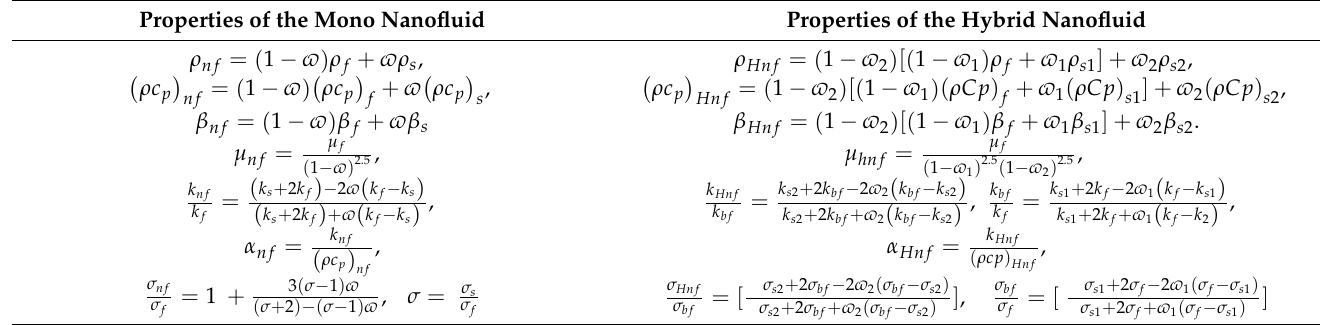
Table 1. Thermo-physical characteristics